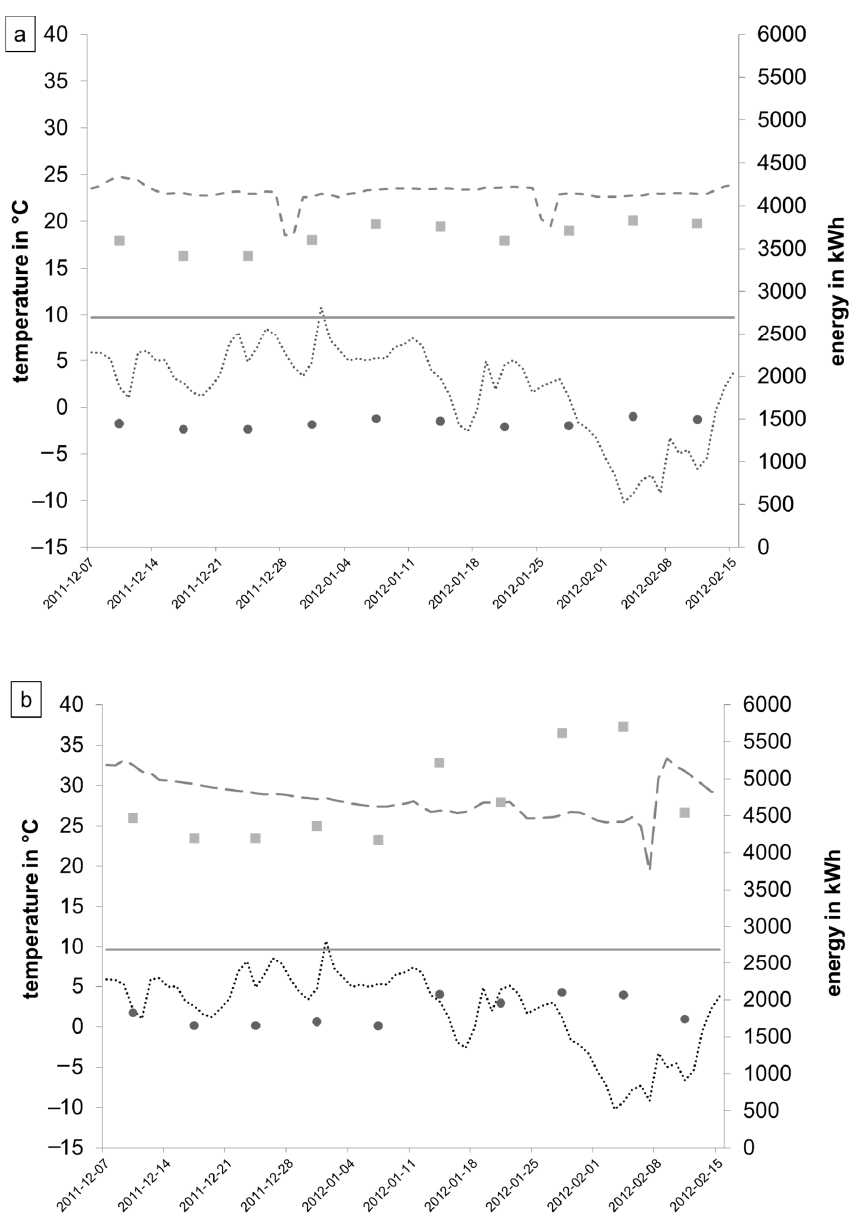
Figure 4. Temperature profiles (hourly mean values) as well as performance of the heat pump(s) (weekly mean values) in ( a ) the farrowing bran and ( b ) the piglet-rearing barn during the trial period. Dotted black line: outside air temperature; dashed grey line: barn inside air temperature; continuous grey line: groundwater temperature; black spots: electrical power consumption of heat pump(s); grey rectangles: heat supplied by the heat pump(s).